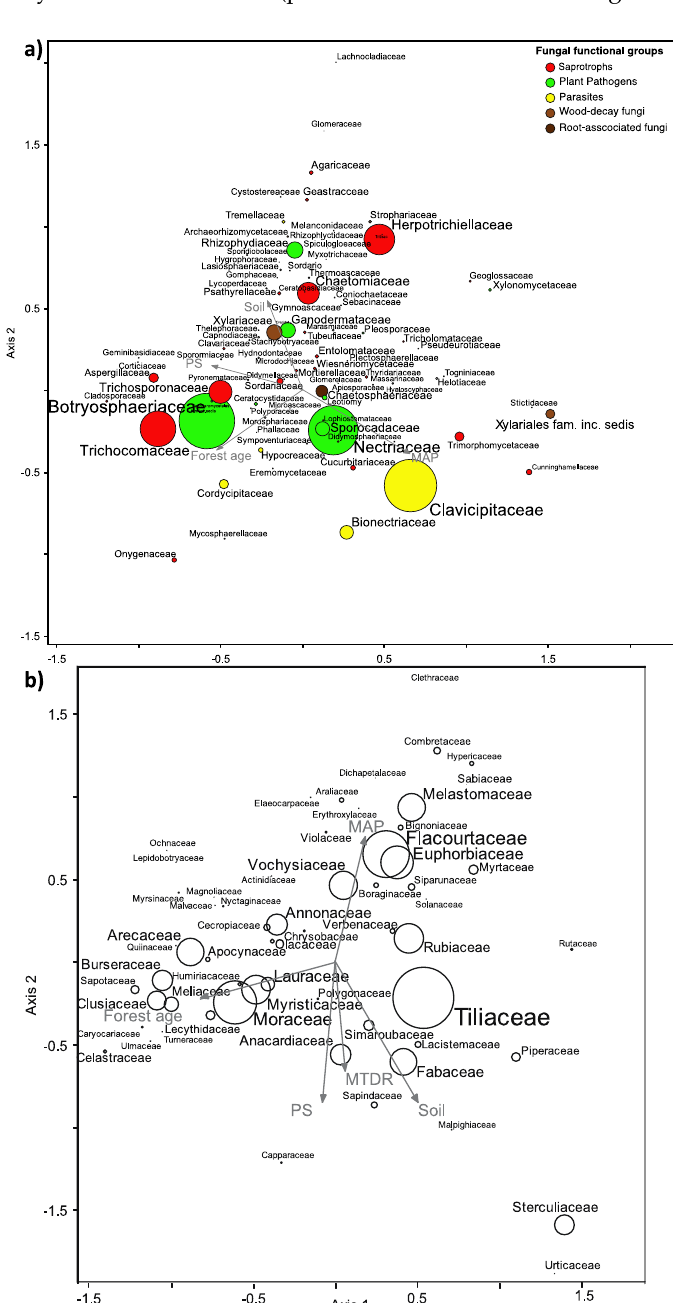
Figure 4. Canonical correspondence analysis (CCA) plots showing the variation in the community composition of ( a ) soil fungi and ( b ) trees using arcsin-transformed relative abundance matrix. Symbols are colored according to functional guilds, and symbol sizes are proportional to the average relative abundance. Abbreviations: MAP: mean annual precipitation, MDRT: mean diurnal range of temperature, PS: precipitation seasonality.